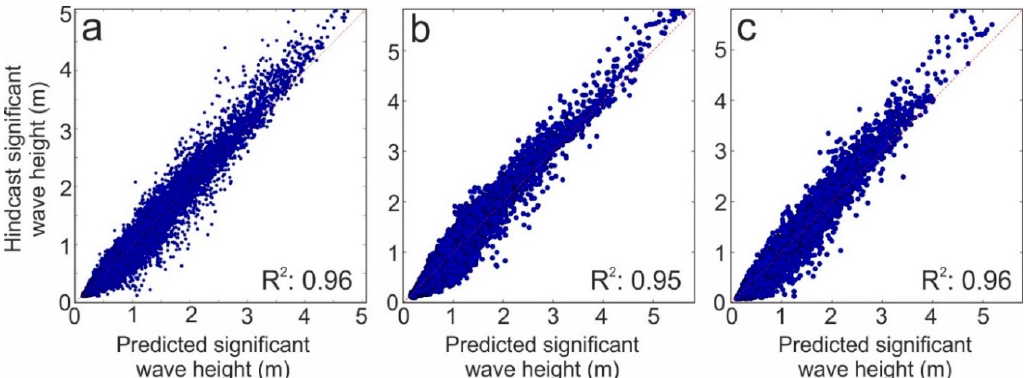
Figure 7. Scatter plots showing the hindcast significant wave height versus the predicted significant wave height from January 2010 to October 2017 for three grid cells, whose locations are indicated in Figure 6. The red dashed line in ( a – c ) is the y = x line. The value of the determination coefficient (R 2 ) is also reported in the plots.